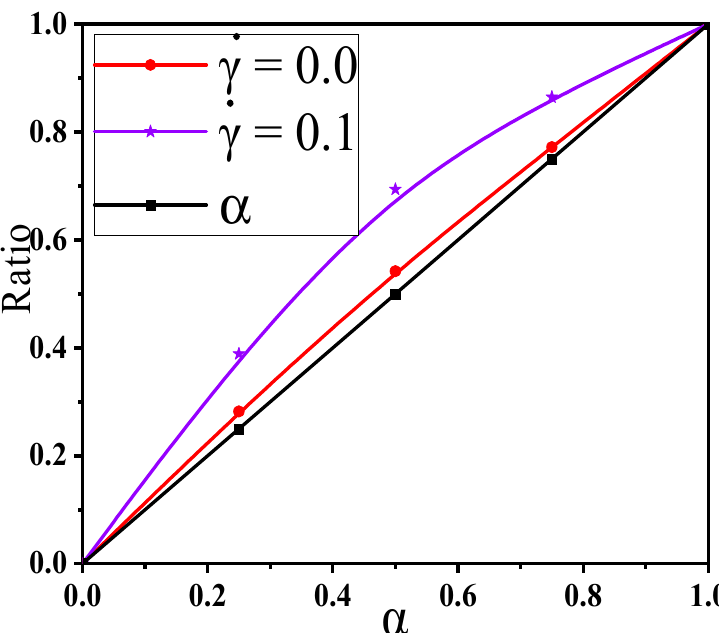
Figure 4. Ratio of big nanoparticles (NPs) to the whole NPs in the largest cluster for two shear rates γ for different mixing ratios ( α